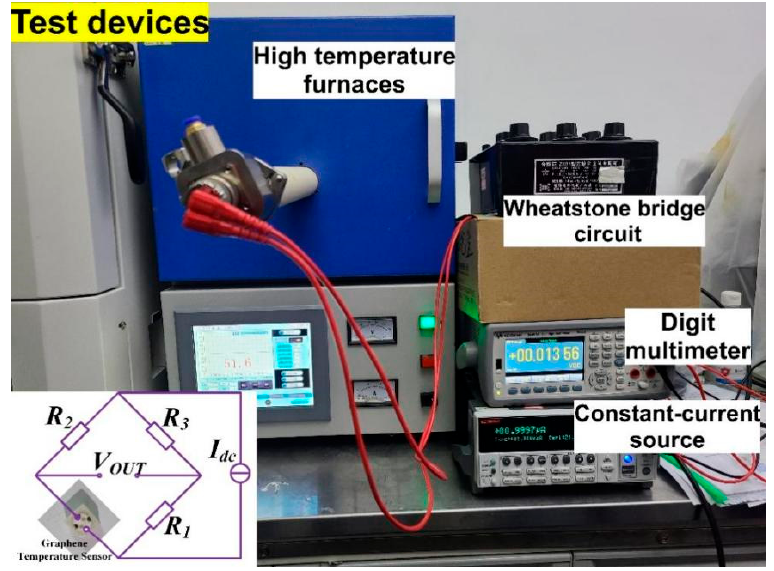
Figure 3. Field test diagram.